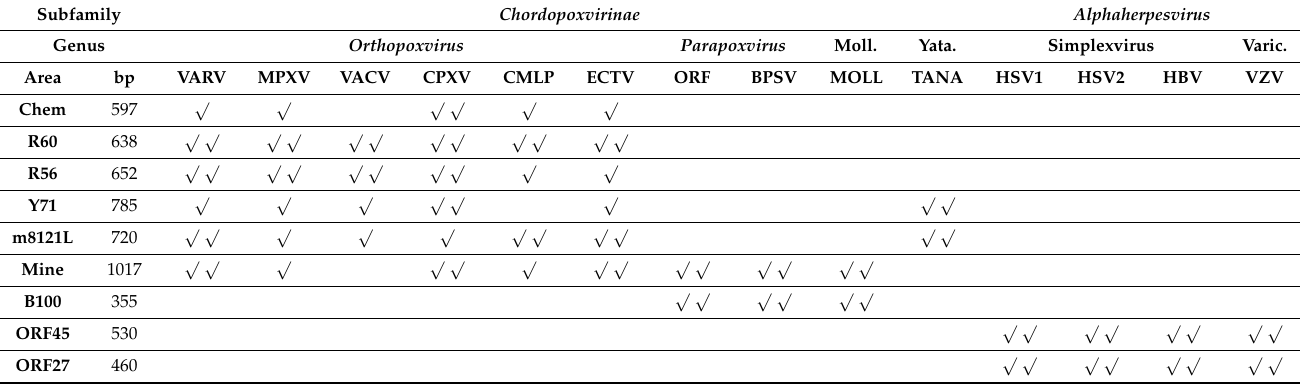
Table 1. Vesicle-forming pathogens and their diagnostic regions in the RANS